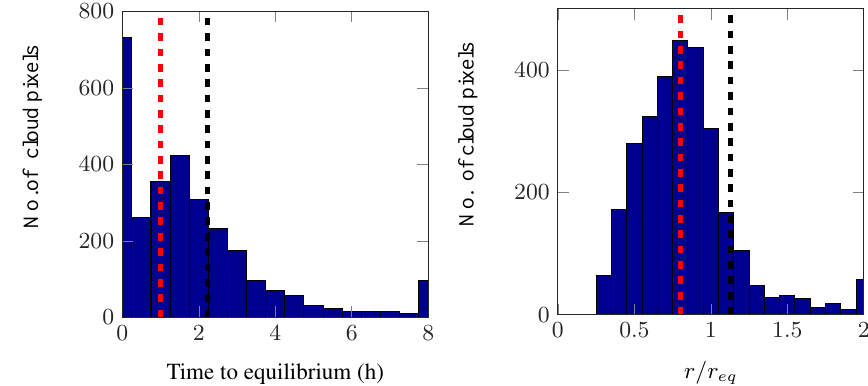
Figure 7. Left: histogram showing the time it will take for the measured pixel to reach equilibrium (not including forbidden clouds) for measurements between 82 and 84km in July. Right: histogram showing the ratio between the measured mode radius and the equilibrium mode radius for the same clouds. r/r eq > 1 indicates that the cloud is sublimating. The median and mean values are given by the vertical red dashed and black dashed lines respectively.